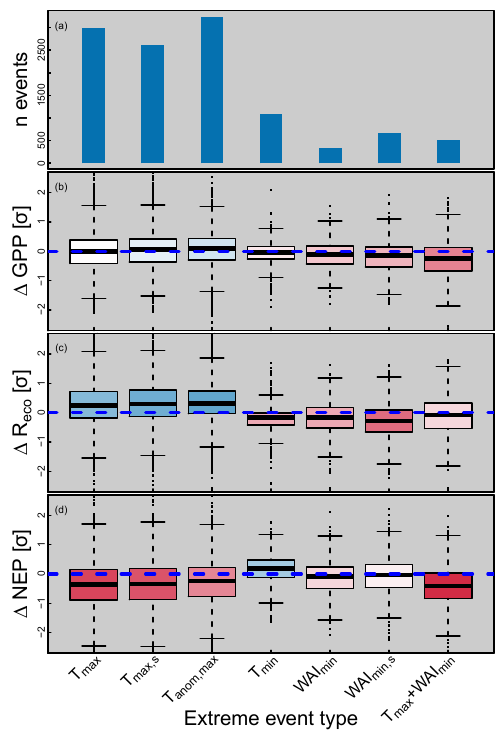
Figure 3. Impacts of different extreme-event types for a selection of different extreme-event types (heat (T max ), heat only (T max, s ), temperature anomalies extreme (T anom, s ), cold (T min ), drought (WAI min ), drought only (WAI min, s ) and combined drought and heat (T max + WAI min ); see Table 1 for details on all extreme types) on gross primary production (GPP), ecosystem respiration (R eco ) and net ecosystem production (NEP). Shown are differences be- tween the normalized fluxes (i.e., their z scores) during a non- extreme reference period and the fluxes during the extreme event ( (cid:49)z = z extr − z ref ; see Eqs. 2 and 3 for details). Box plots are color- coded according to the median of the distribution with shades of blue (for positive values, i.e., a flux increase during the extreme event) and red (for negative/decreased values). Panel (a) shows the amount of growing season extreme events detected for each event type. Panel (b) shows the impacts on GPP, (c) on R eco and (d) on